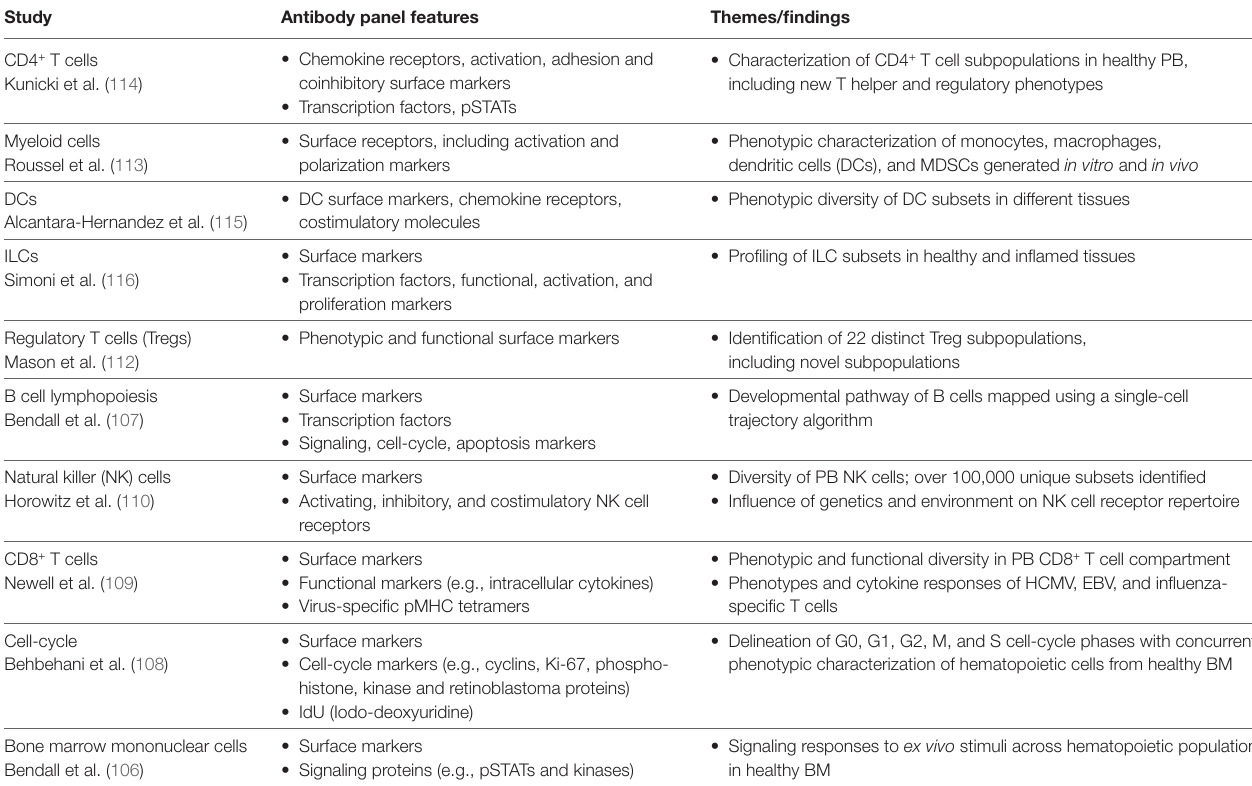
TABLe 1 | Examples of studies using mass cytometry for human immunology